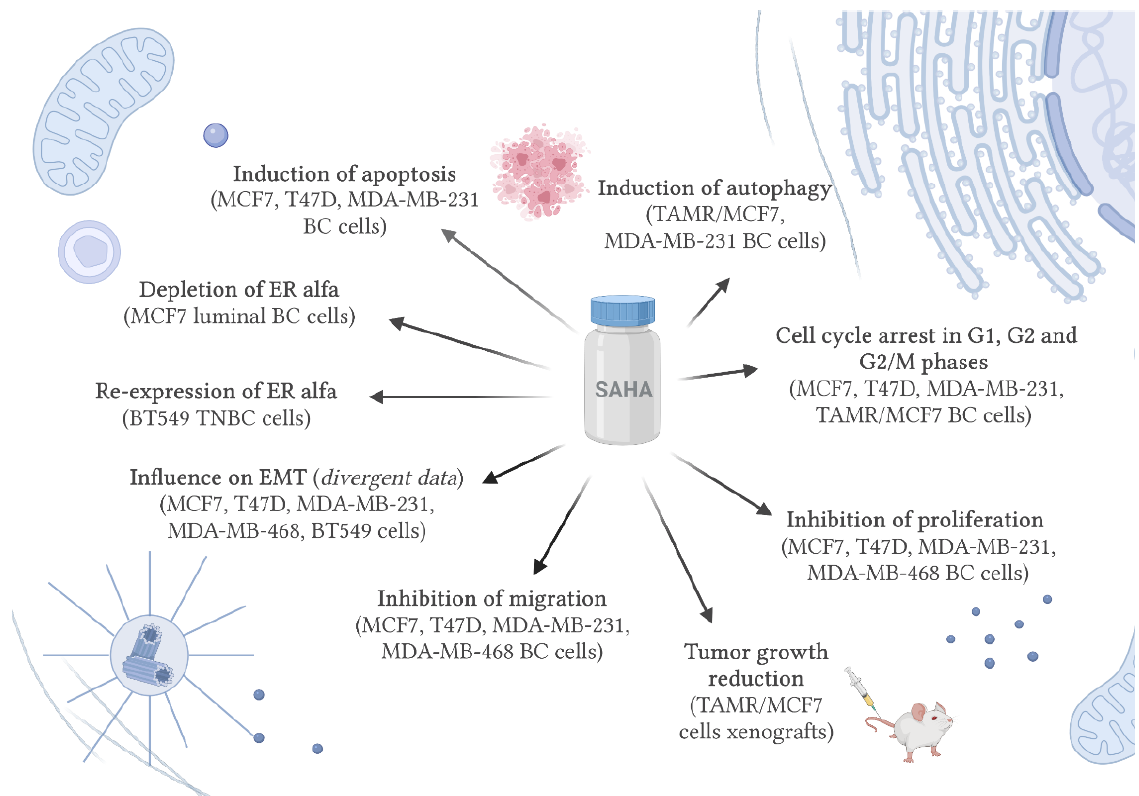
Figure 2. The functional mechanism of vorinostat (SAHA) in breast cancer in vitro and in vivo settings (BC-breast cancer, ER-estrogen receptor, EMT-epithelial-mesenchymal transition, SAHA-vorinostat, TAMR-tamoxifen-resistant, TNBC-triple-negative breast cancer).